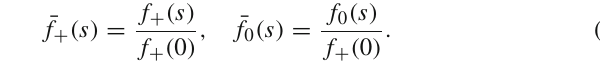
Table 2 Input quantities entering Eq. (21)